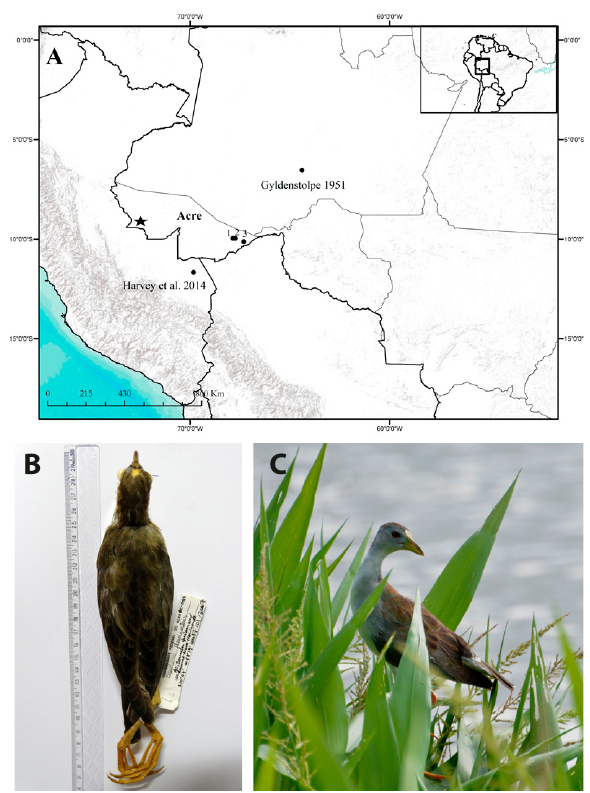
Figure 4. (A) Record of the Azure Gallinule ( Porphyrio flavirostris ) in southwestern Amazon: 1, Campus of the Federal University of Acre (UFAC) in Rio Branco; 2, São Raimundo farm; 3, Novo Horizonte road, and location of the previous undocumented record of Whittaker et al. (2002) (black star) and surrounding states (specified black dots); (B) Specimen from Novo Horizonte (voucher number AC-181) and; (C) Individual recorded on 23 December 2016 in the UFAC campus Rio Branco. Photos by Edson